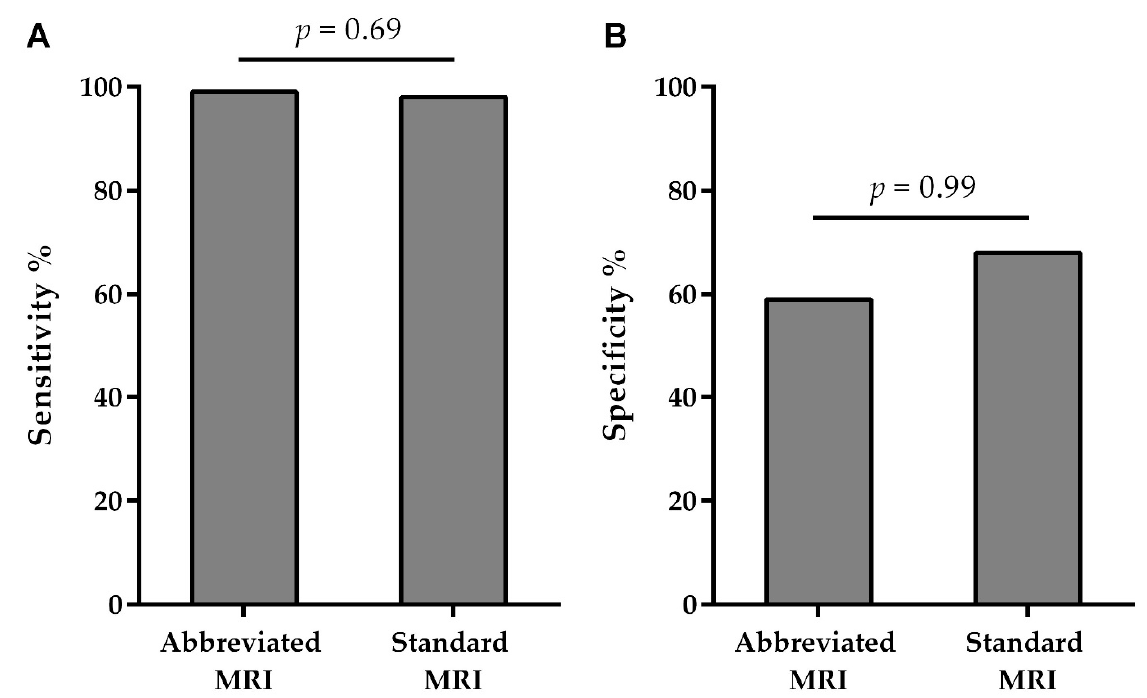
Figure 2. Comparison of the sensitivity ( A ) and specificity ( B ) of the two protocols used (abbreviated vs. standard MRI protocol).